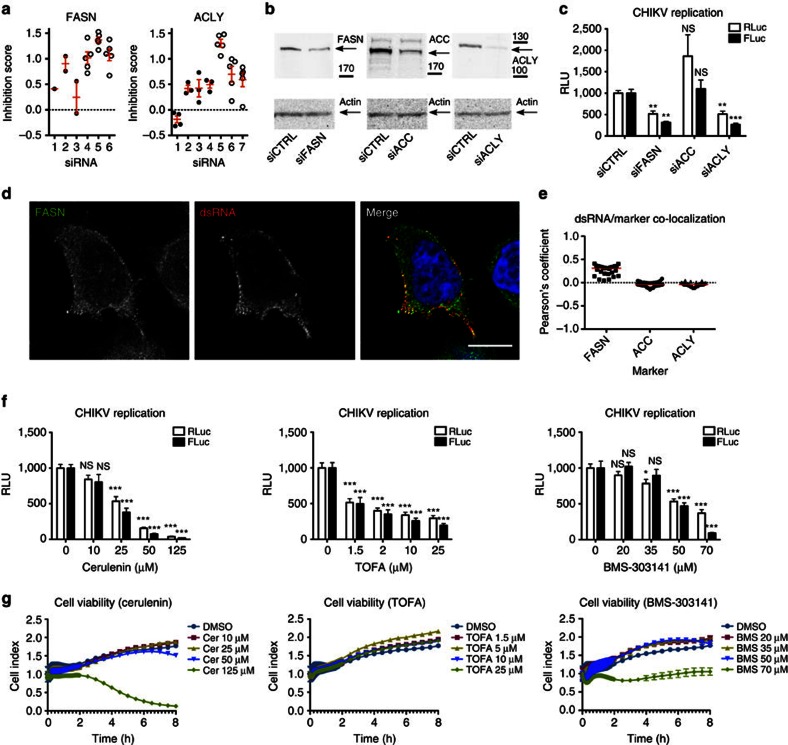
Fatty acid synthesis requirement for CHIKV life cycle.(a) Impact of FASN or ACLY knockdown on CHIKV replication. Closed and open symbols indicate replicates from the primary screen and during validation, respectively. (b) Western blot showing silencing efficiency of siRNAs used in c. (c) Impact of FASN-, ACC- and ACLY-specific siRNAs on CHIKV replication (n=10 for each data set). (d) Confocal section of CHIKV replicon-infected HeLa cells labelled for FASN, dsRNA and 4,6-diamidino-2-phenylindole (DAPI; blue). Scale bar, 10 μm. (e) Co-localization analysis of cells labelled as in d and in Supplementary Fig. 3b, plotted as Pearson's coefficient per cell. Each symbol corresponds to a cell stack from three independent experiments (n=29 cells for FASN, 30 cells for ACC and 31 cells for ACLY); median values shown in red. (f) Effect of FASN (cerulenin, n=12 for each data set), ACC (TOFA, n=11 for each data set) and ACLY (BMS-303141 n=11 for each data set) inhibitors on CHIKV replication. (g) Real-time cell toxicity assay performed on HeLa cells (n=3 for each point). Excepted for b and d where representative images are shown and for g where the mean±s.d. is shown for each point of a representative experiment, all data represent the means±s.e.m. of three independent experiments analysed using one-way analysis of variance with Tukey's post test (*P<0.05; **P<0.01; ***P<0.001; NSP≥0.05). NS, not significant.